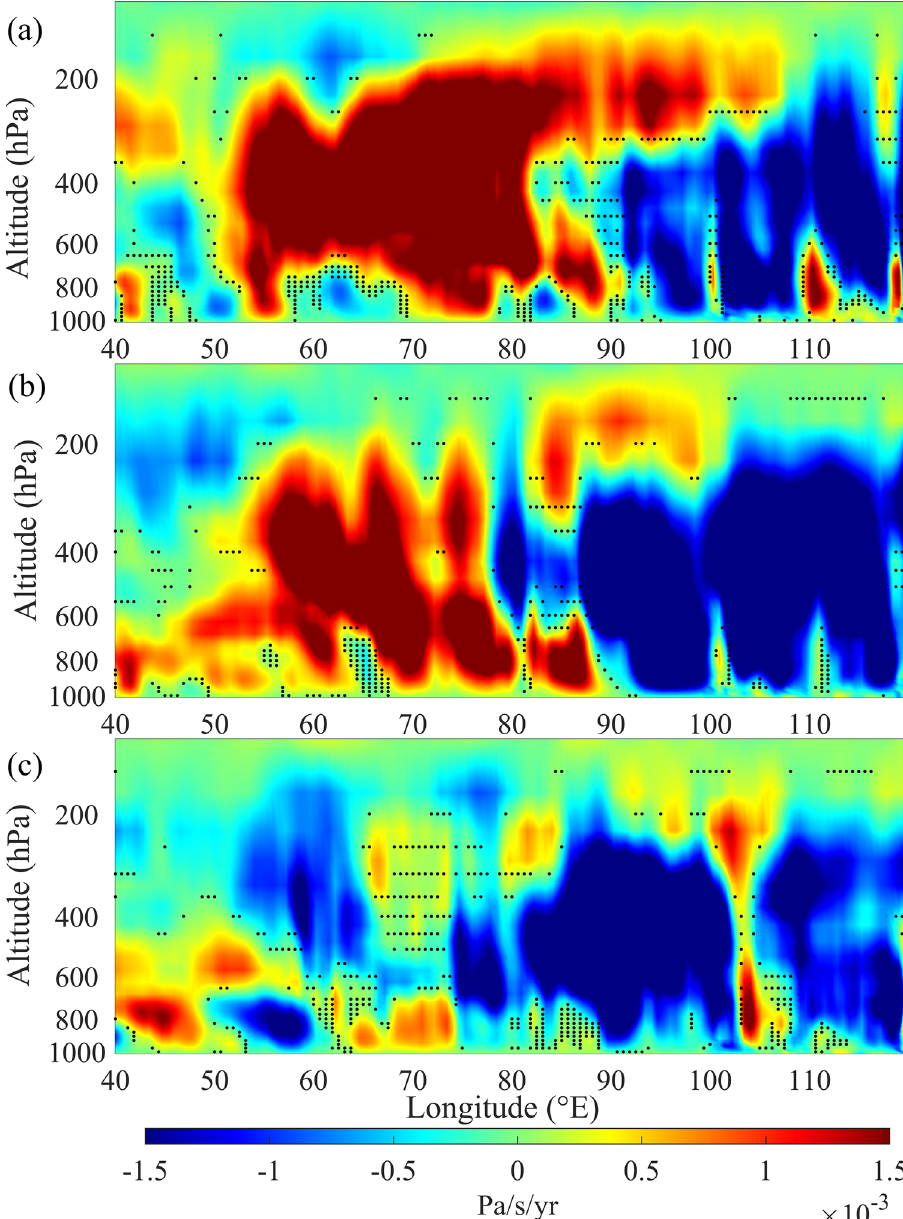
Figure 5. Trends of vertical winds in summer monsoon months: Trends of vertical wind averaged over the latitude band between 10° S and equator, in ( a ) June, ( b ) July and ( c ) August during 2000–2017, by excluding El Niño and La Niña years. In order to maintain uniformity, El Niño and La Niña years are considered based on the ONI values corresponding to August. Black dots show the regions where trends are not significant at 95% confidence level. Positive values indicate strengthening (weakening) of downward (upward) wind and negative values indicate vice